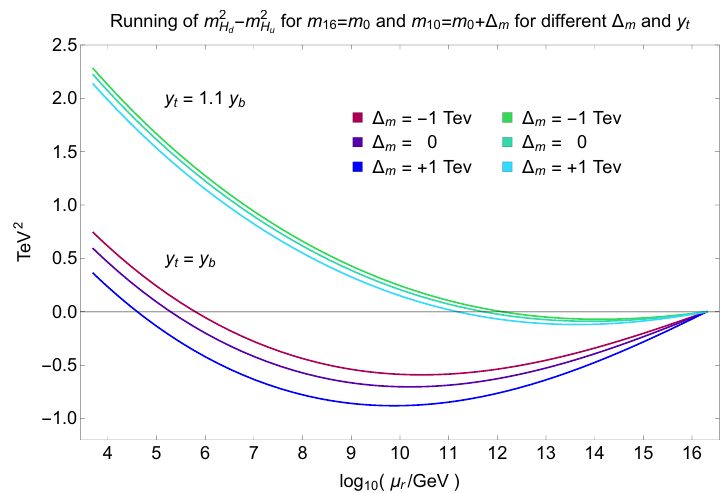
Figure 7 . The RGE running of m 2 (cid:0) m 2 for di(cid:11)erent splits (cid:1) m in the soft mass parameters H d H u consistent with SO(10) uni(cid:12)cation: we take m 16 = m 0 and m 10 = m 0 +(cid:1) m , with m 0 of the example point (3.11){(3.20). We plot two sets of trajectories: the red-to-blue trajectories are for y t = y b ( t - b uni(cid:12)cation), while the green-to-cyan trajectories are for the case y t = 1 : 1 y b .